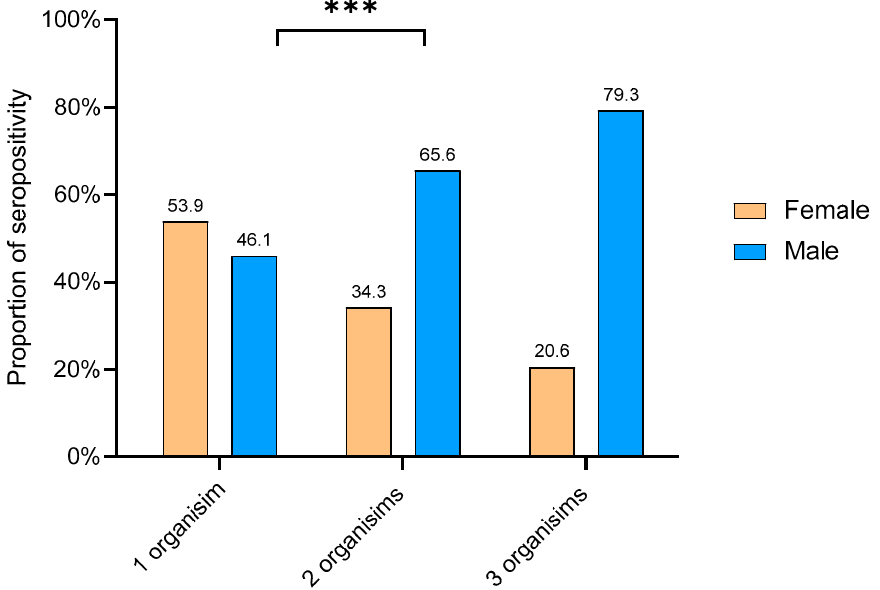
Figure 5. Distribution of IgG seropositivity among male and female participants in the different seropositivity groups. (***) p -value =